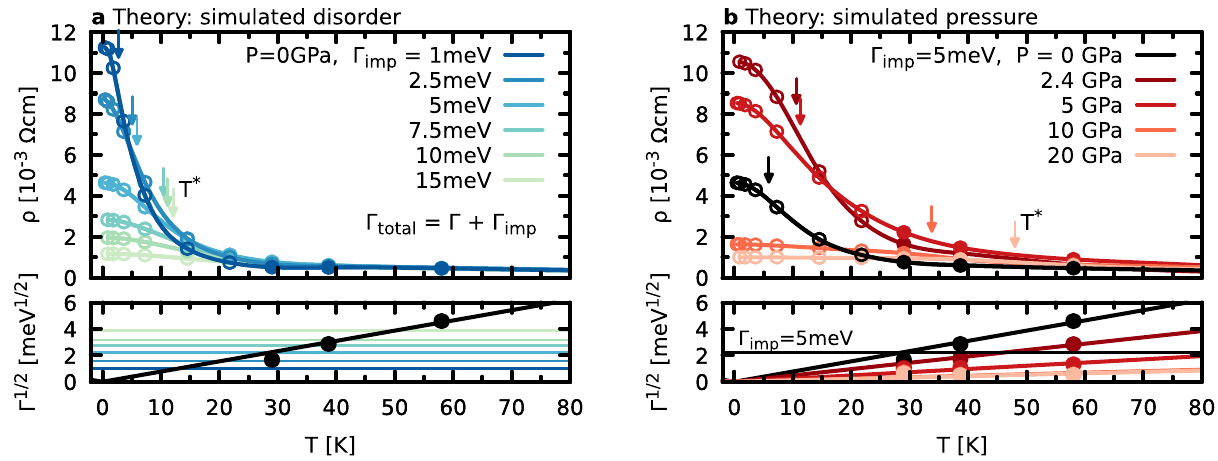
Fig. 2 Simulated resistivity of Ce 3 Bi 4 Pt 3 . Shown are results for the resistivity ρ ( T ) a at ambient pressure ( P = 0) for varying impurity scattering Γ imp (shades blue to green) and b at different pressures P (shades of red) for fi xed impurity scattering Γ imp = 5 meV. Filled circles in ρ ( T ) indicate simulation temperatures; results shown by open circles have been obtained by extrapolating the many-body scattering rate Γ ( T ) with a quadratic fi t. Vertical arrows indicate in fl ection points T * in ρ ( T ). The simulations mirror the experimental trends: T * varies signi fi cantly with pressure, but depends only weakly on disorder. While transport simulations include the full self-energy Σ ( ω ), it is instructive to quantify electron-electron scattering: we display the square root (cid:6) (cid:7) fJ = 5/2 components); black and red-shaded of Γ ¼ (cid:2) Im Σ ð ω ¼ 0 Þ J ¼ 5 = 2 , the simulated many-body scattering rate at the Fermi level (averaged over Ce-4 lines are linear fi ts to Γ 1/2 of simulated points, suggesting that for all pressures: Γ = γ T 2 ; γ decreases notably under compression, indicative of weakening correlation effects. Horizontal lines (shades of blue and green in a ; dotted line in b ) indicate the additional impurity-scattering rate Γ imp . The total rate is the sum: Γ total = Γ + Γ imp .